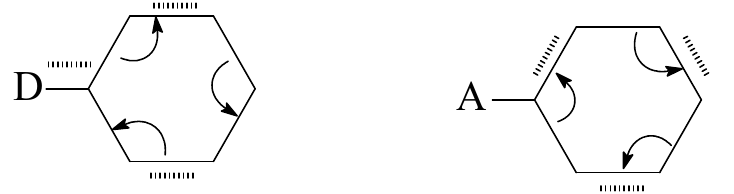
Figure 4. Structures of substituted cyclic hydrocarbon and the effect of donor and acceptor substit- uents. Electron-donating (D) or electron-acceptor (A) groups are shown (the wavy lines mark the shortened lengths of C—C bonds, and the arrows indicate the increased valence angles of C atoms in the benzene cycle).